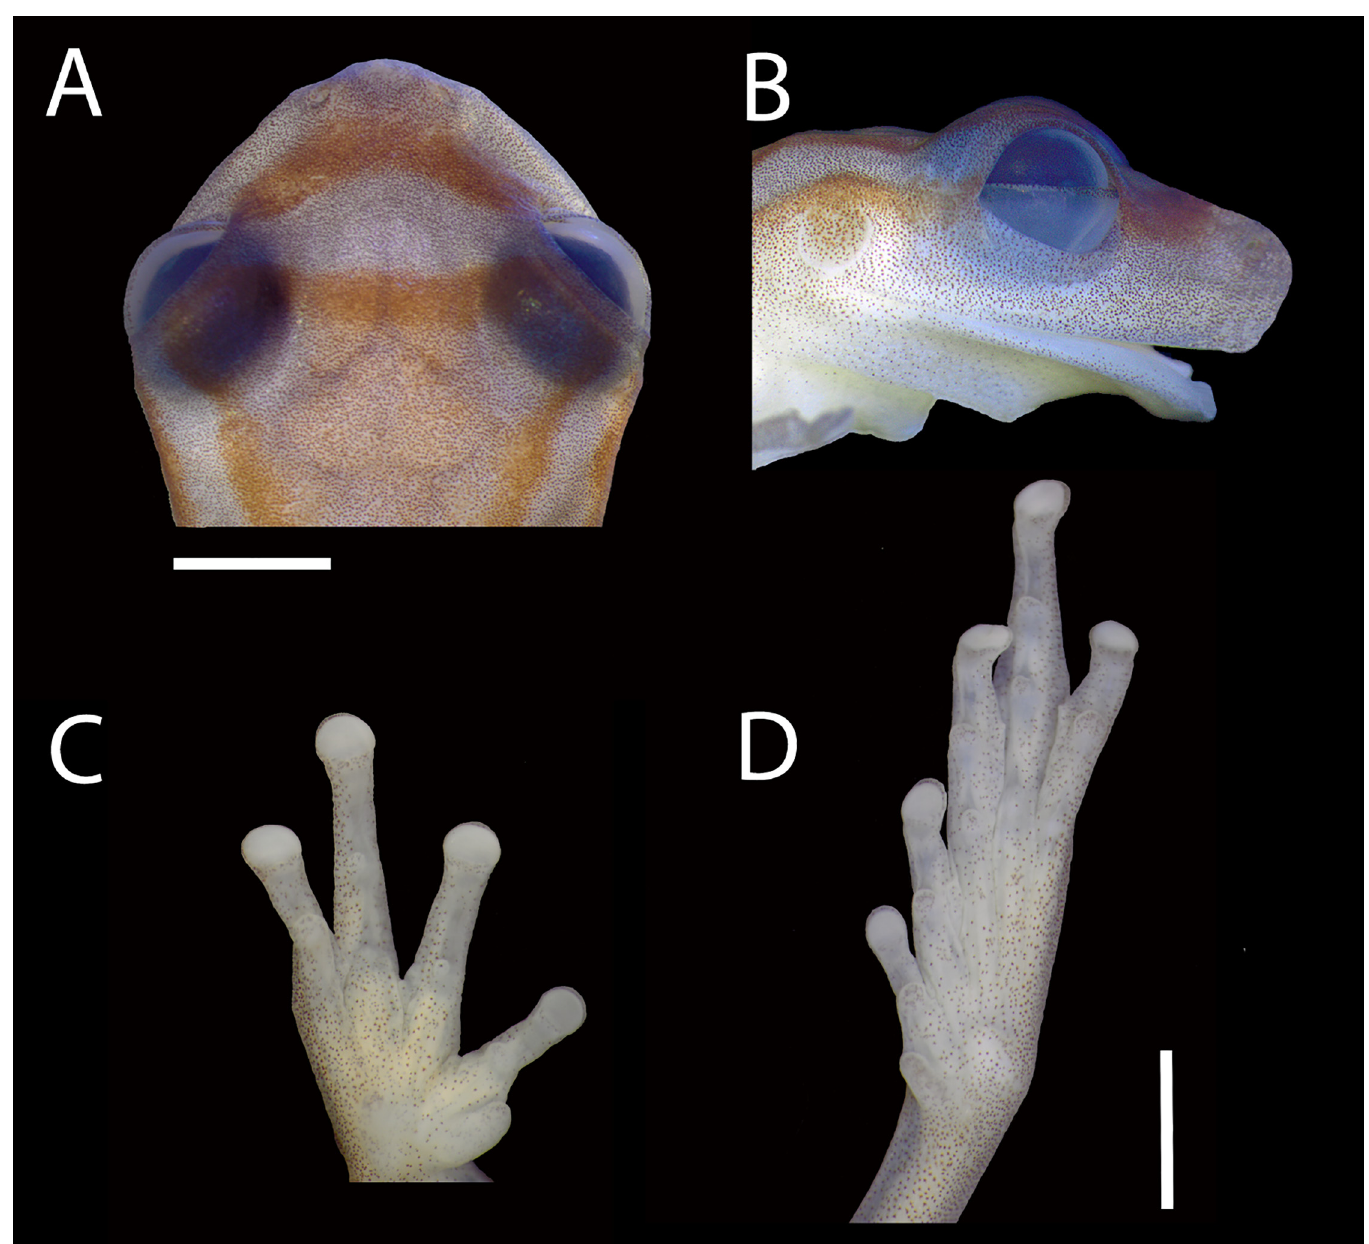
Fig 2. Holotype of Dendropsophus bromeliaceus sp. nov.. (A) Dorsal and (B) lateral views of head, (C) palmar view of left hand, and (D) plantar view of right foot (MNRJ 85852). Scale bar = 2 mm. circular from eye to above the arm insertion; tympanum small (TD/HL 0.16), distinct, rounded, separated from the eye; choanae medium size, oval; vomerine odontophores very small; tongue large, cordiform, slightly notched behind; vocal slits long, extending from midlat- eral base of tongue to almost the angle of jaws; vocal sac, medium sized, and subgular. Arm slender; forearm more robust than upper arm; arm without fold or fringe; axillary membrane reduced; fingers slender; relative length of fingers II < III (cid:1) V < IV; discs nearly round, small;